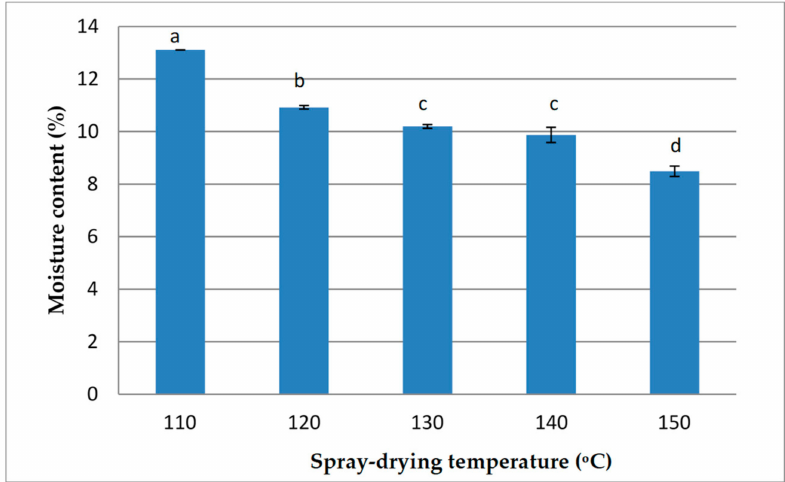
Figure 2. Moisture content (%) of lemongrass leaf extract powders at different spray-drying temperatures. All data are the mean ± SD. Values with different letters are significantly different ( p <